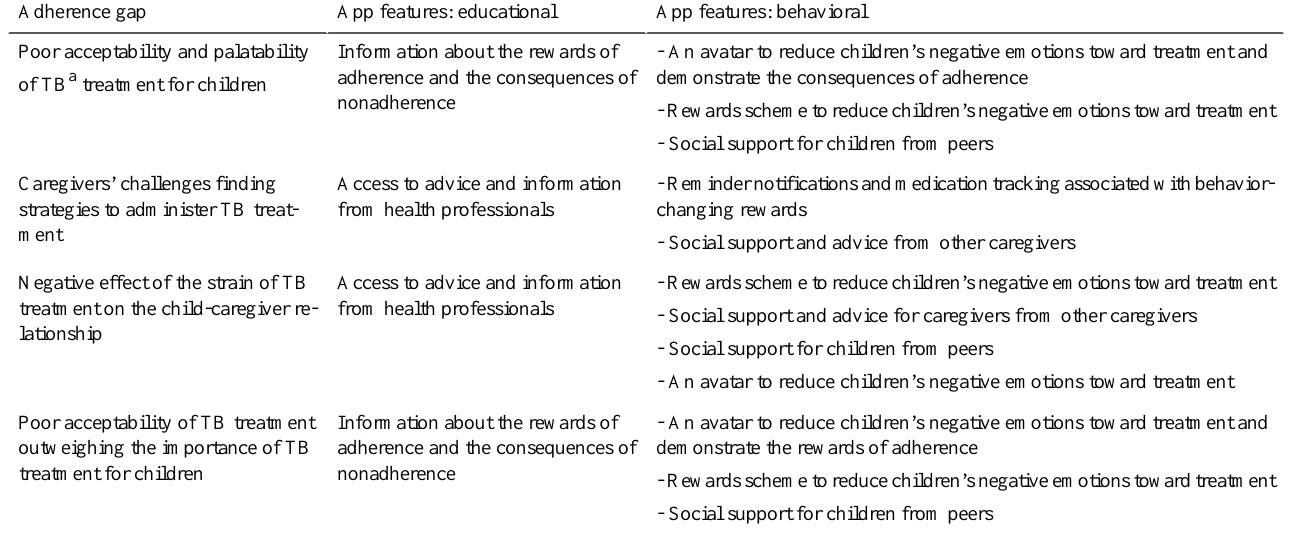
Table 2. Summary of adherence gaps and their hypothetical corresponding mobile app features.